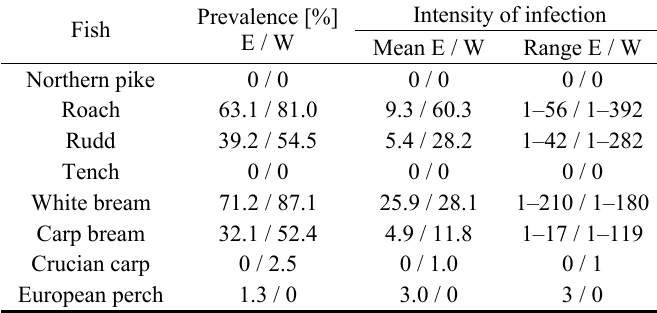
Comparison of the fish infection with Posthodiplostomum cuticola in the eastern (E) and western (W) part of OÊwin Lake